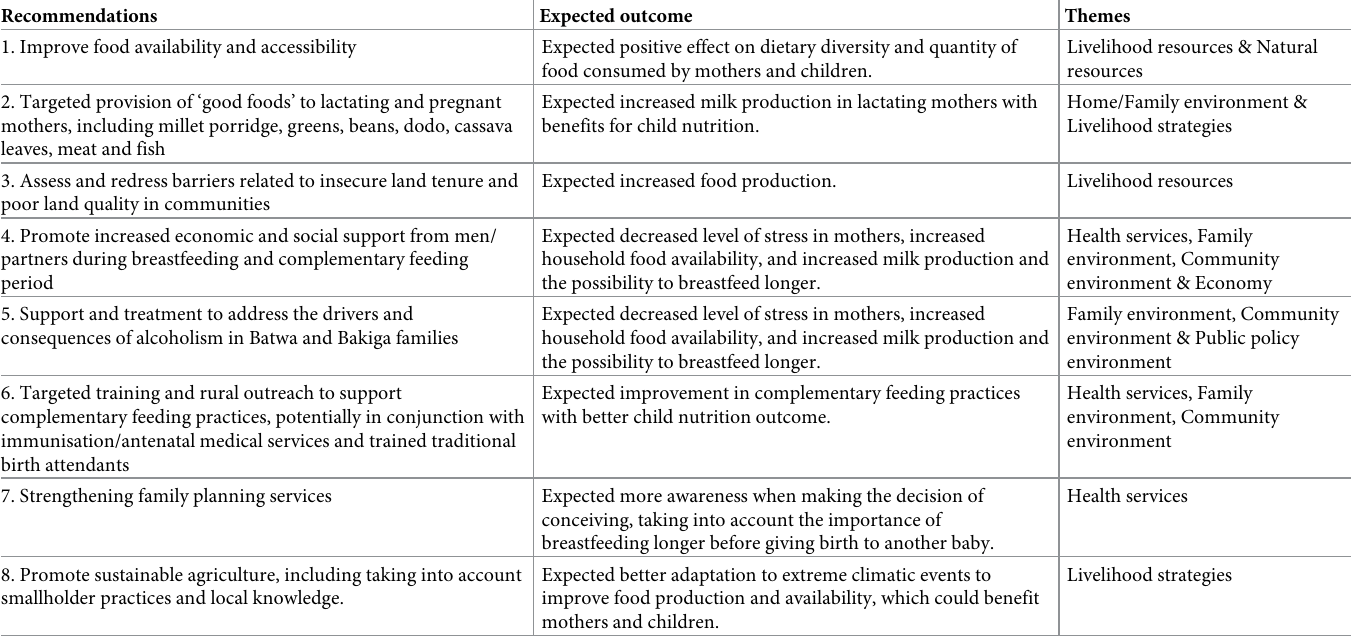
Table 4. Summary of recommendations to improve child and maternal